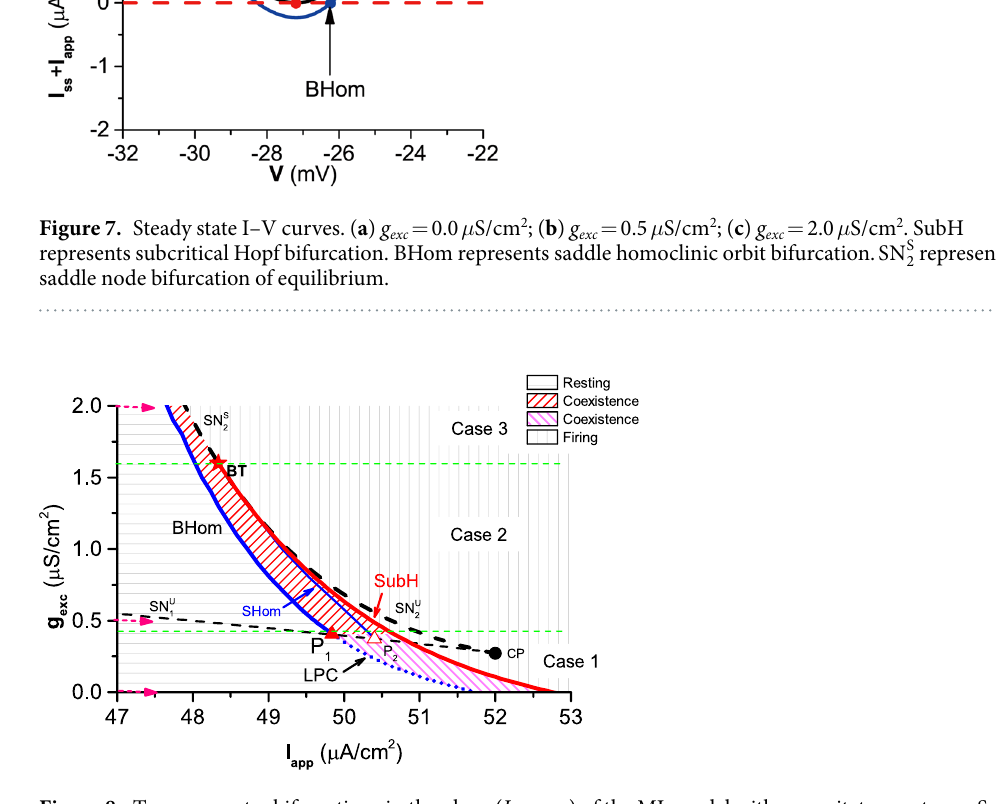
Figure 8. Two parameter bifurcations in the plane ( I app , g exc ) of the ML model with an excitatory autapse. SubH is subcritical Hopf curve. BHom and SHom are saddle homoclinic orbit bifurcation curves. SN 1S , SN 1U , SN 2S and SN 2U are curves of saddle node bifurcation of equilibrium. LPC represents the curve of saddle node bifurcation of limit cycle. CP is cusp bifurcation. BT is Bogdanov-Takens